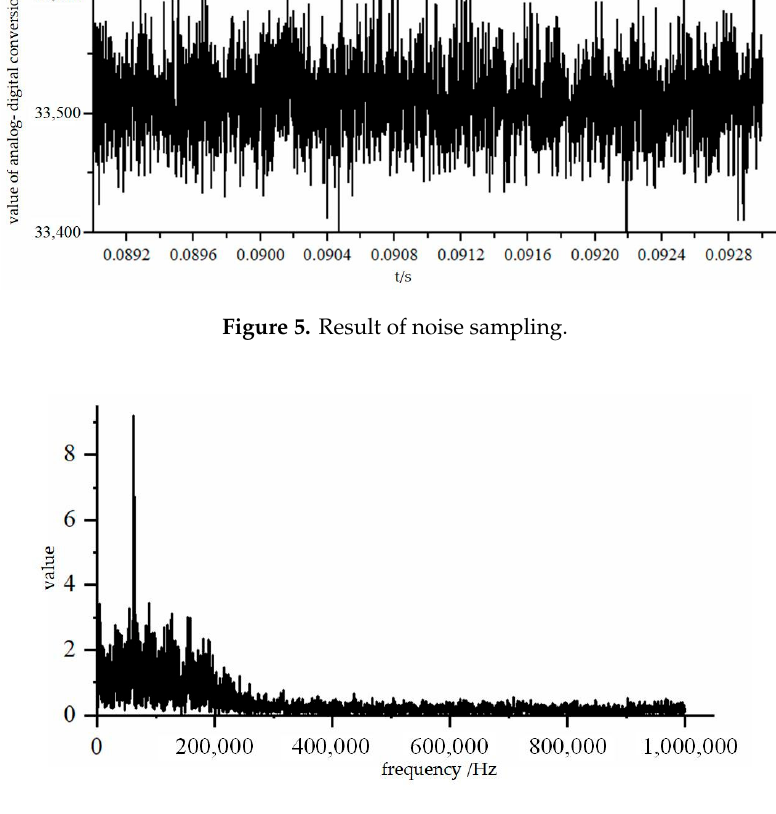
Figure 6. Distribution of noise frequency.